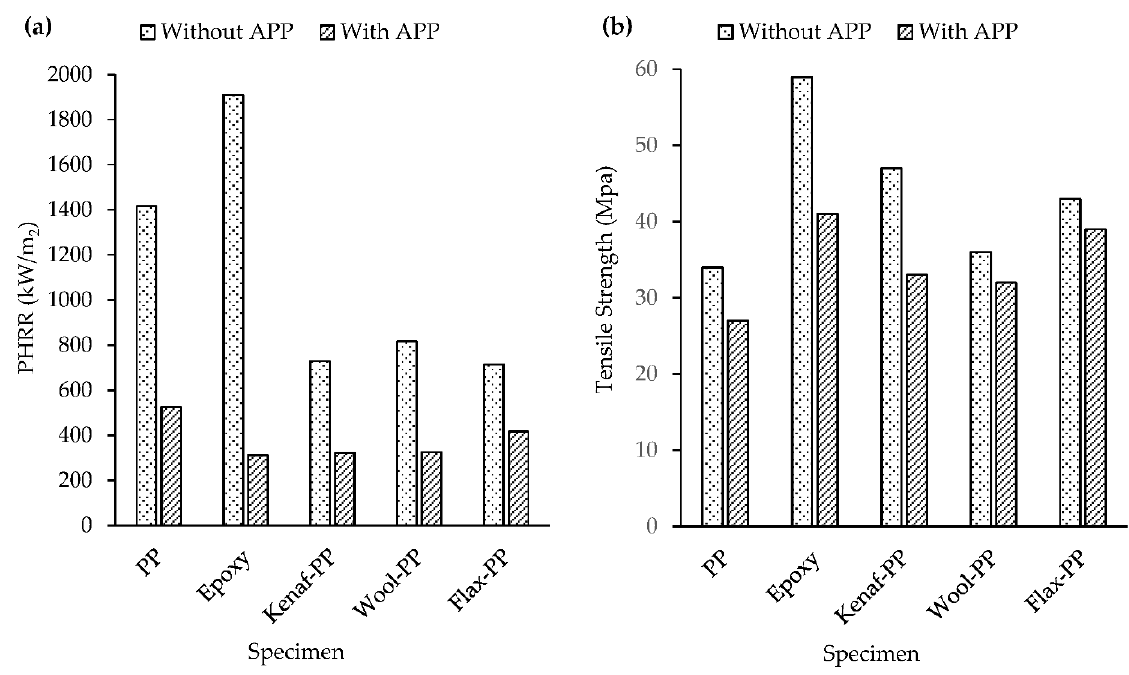
Figure 1. Effects of APP on ( a ) Peak heat release rate and ( b ) tensile strength of polymers and their composites.